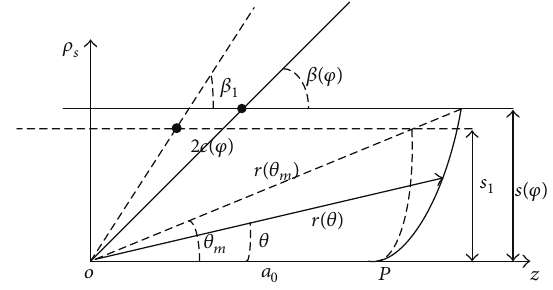
Figure 3: Parameters of arbitrary 𝜑 plane.